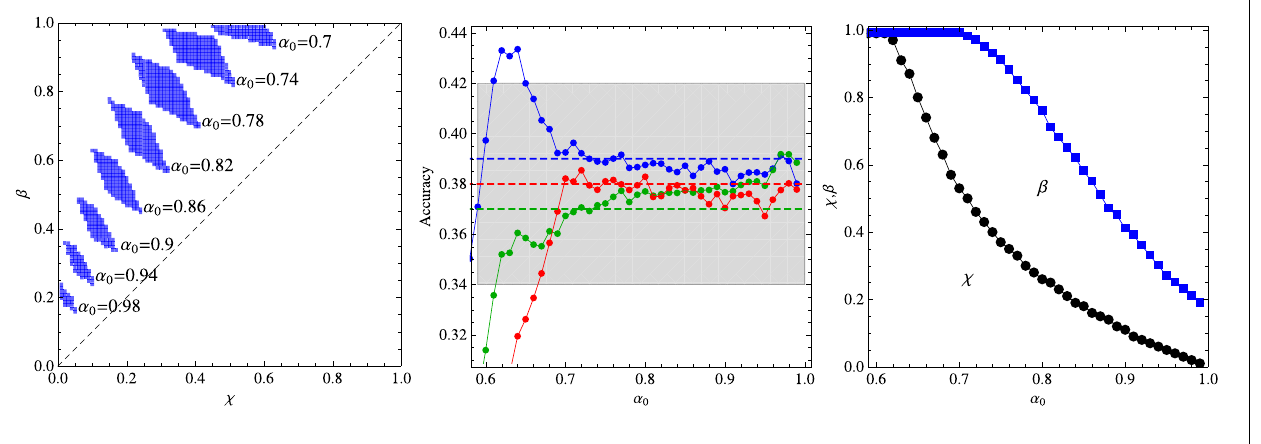
FIGURE 2 | Summary of the results for the three-frequency condition experiment. Left panel: Regions in the plane ( χ , β ) where the algorithm fits the experimental data for fixed α 0 as indicated in the figure. Middle panel: Average accuracy for the best fit to the results of Experiment 1 of Kachergis et al. (2009) represented by the broken horizontal lines (means) and shaded